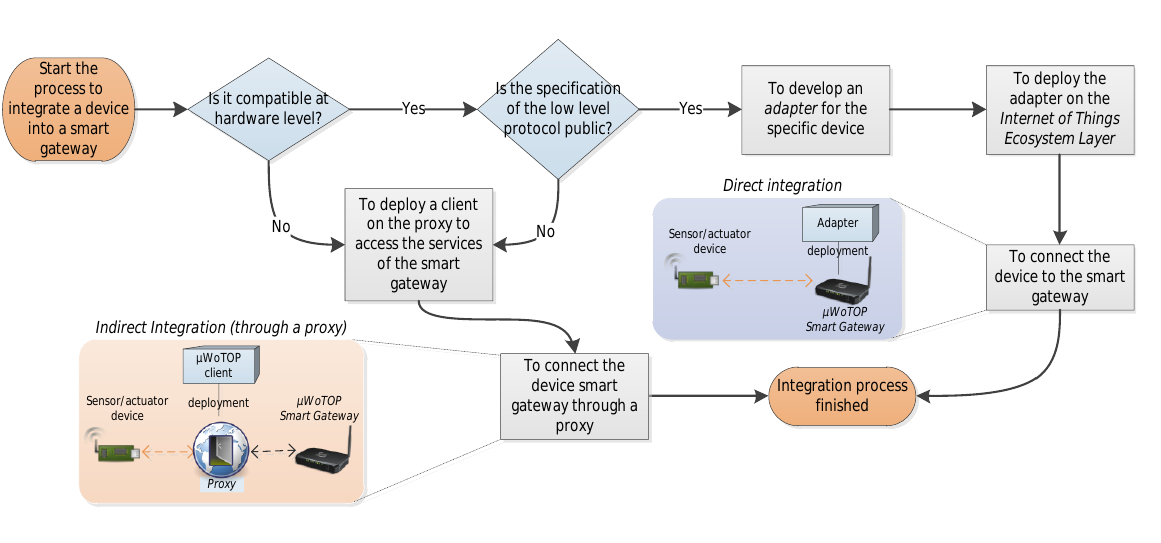
Figure 6. Integration process to connect sensor and actuator devices to the smart gateway running µ